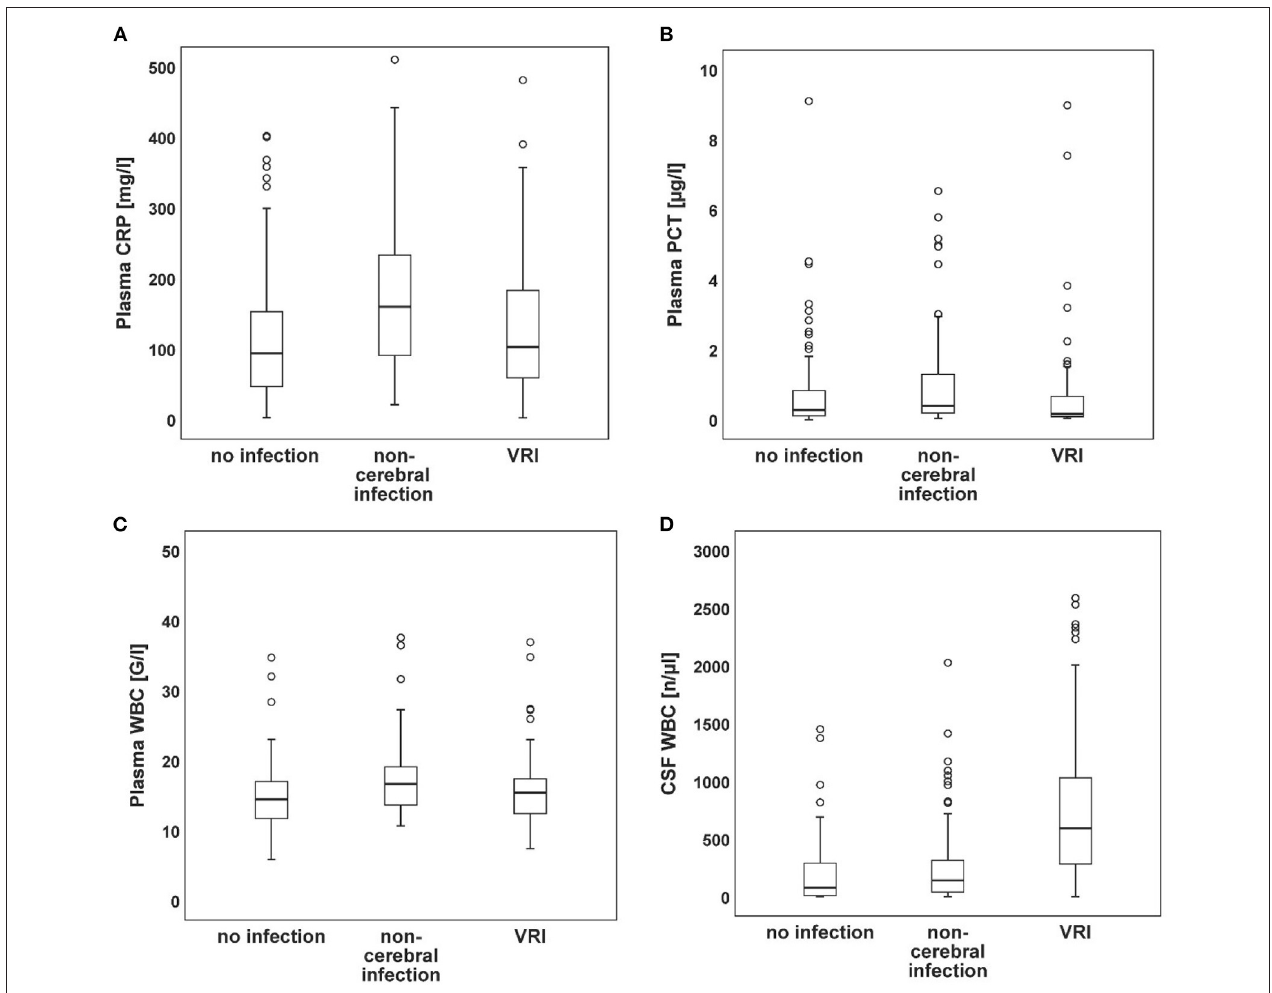
FIGURE 2 | Peak values of plasma and CSF-derived parameters. Box plots of CRP (A) , PCT (B) , plasma WBC (C) , and CSF WBC (D) peak values showing the median (horizontal line), the first and third quartile (lower and upper end of box), the minimum and maximum (whiskers), and outliers (circles; values outside 1.5 times the interquartile